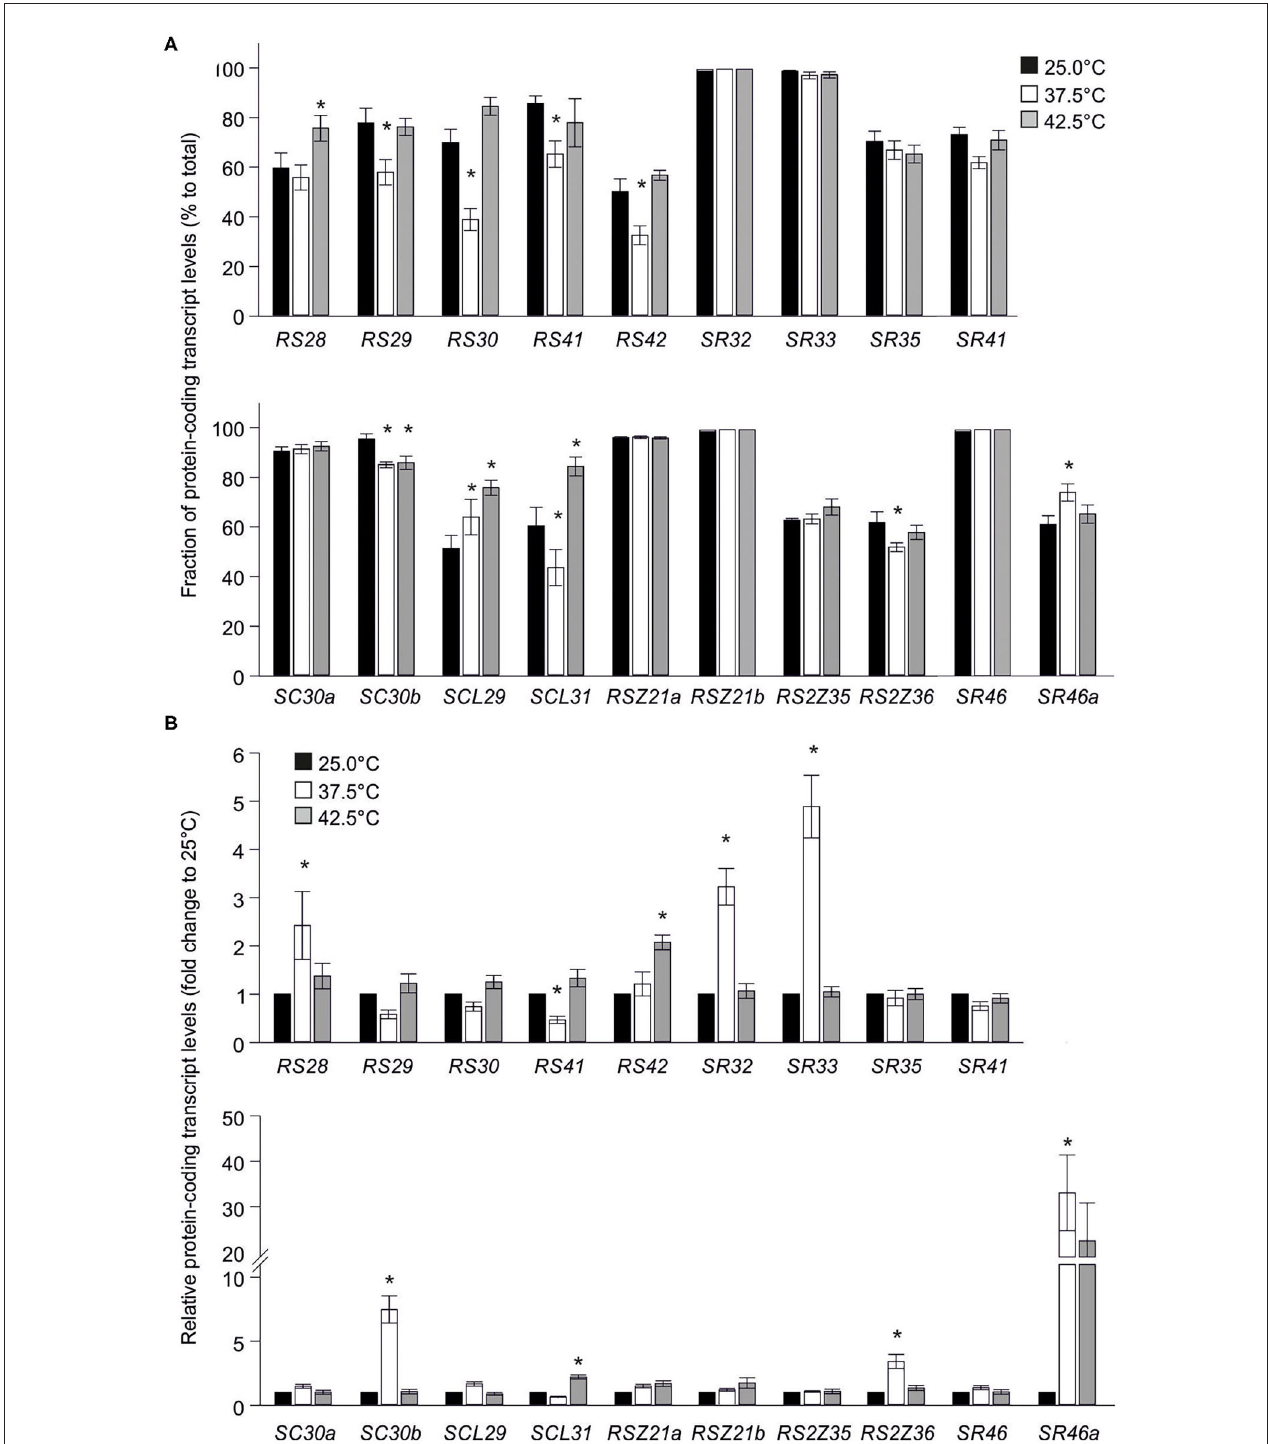
FIGURE 6 | Effect of elevated temperatures on transcript levels of tomato SR and SR-like coding genes. (A) Levels of SR and SR-like protein-coding transcripts in tomato leaves exposed to 25, 37.5 or 42.5 ◦ C for 1h, relative to total transcripts. Transcript levels were determined as in Figure 5 . (B) Relative levels of transcripts of SR protein-coding isoforms in young leaves of tomato plants exposed to 25, 37.5 or 42.5 ◦ C for 1h. The levels of heat stressed samples are expressed as relative to the control (25 ◦ C) sample (1-fold) and calculated with the 2 − 11 Ct method (Livak and Schmittgen, 2001) using EF1 α as control. Values are the average of six independent biological replicates and asterisks indicate statistically significant difference to control ( > 2-fold change and p < 0.05 based on ANOVA with Duncan post hoc test).